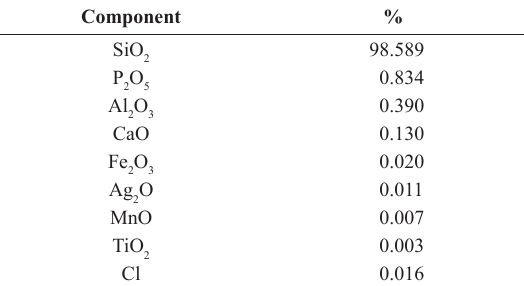
from rice husk and 2